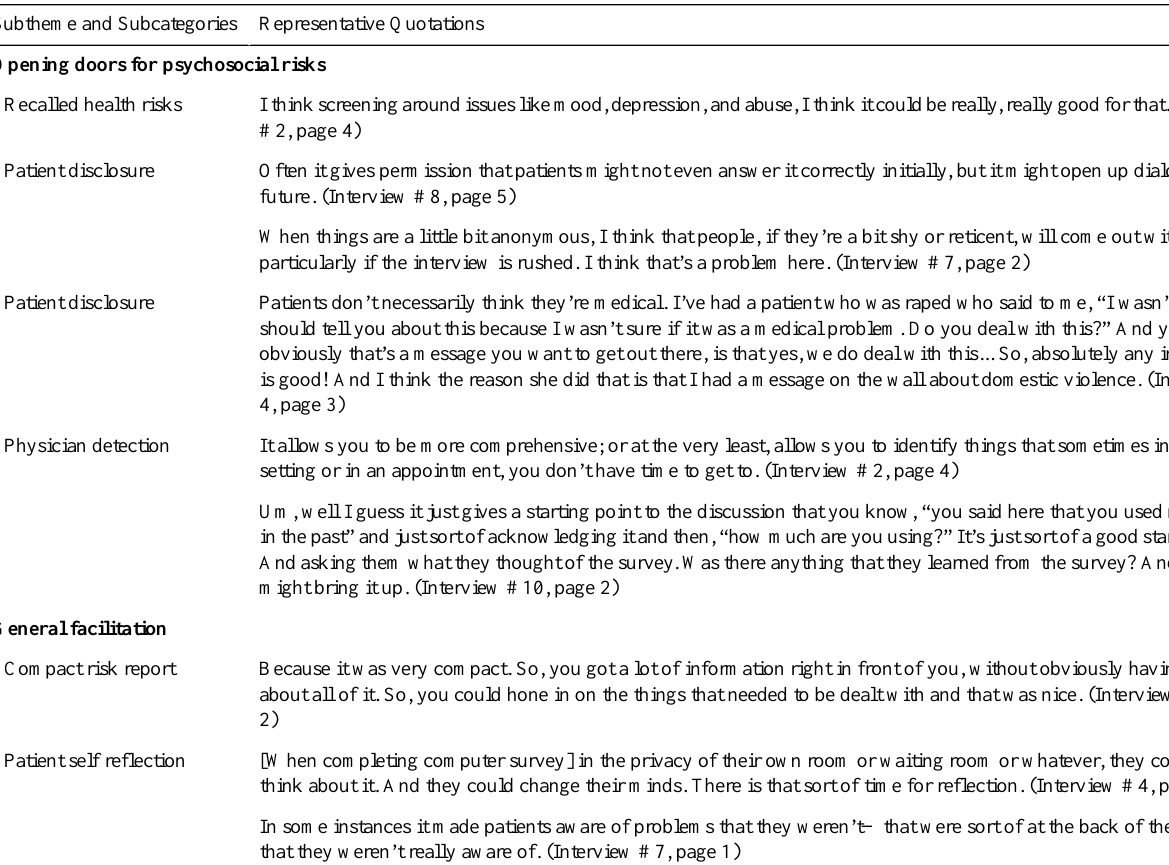
Table 1. Physician perceived benefits of the computer-assisted HRA Representative QuotationsSubtheme and Subcategories Opening doors for psychosocial